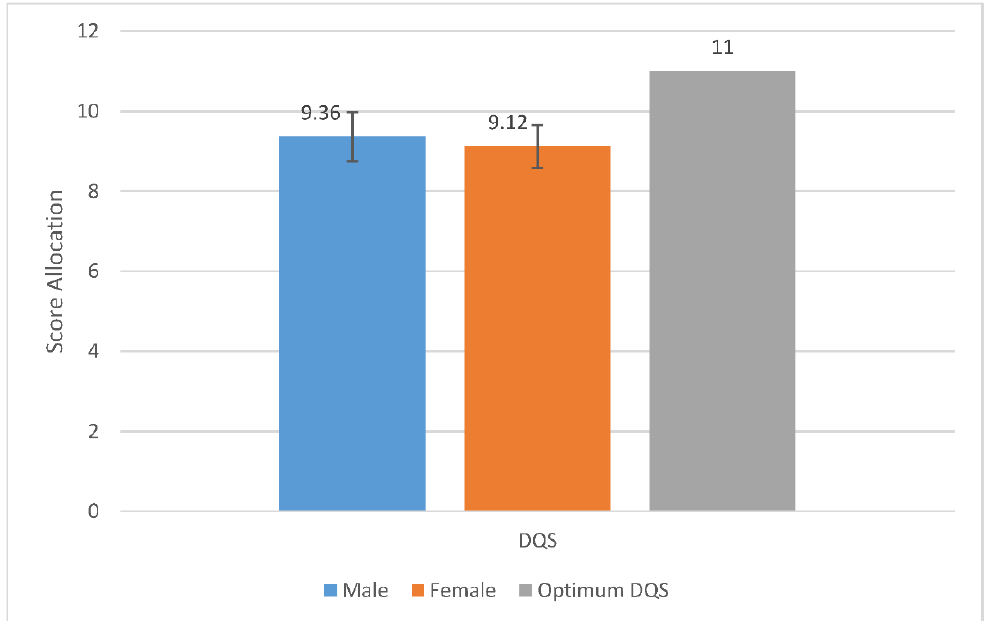
Figure 2. Mean DQS from the Short Form FFQ, evaluated using DANTE tool per sex compared to the optimum DQS.